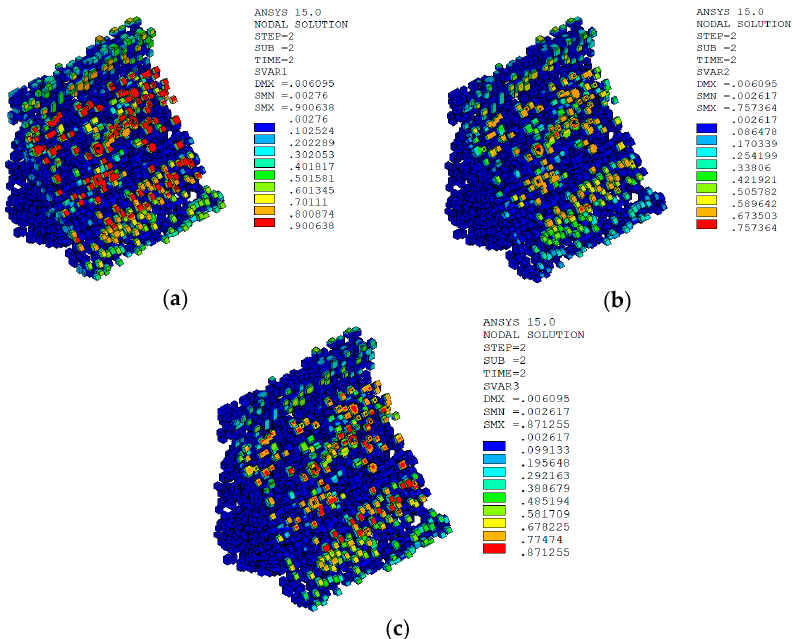
Figure 16. The temperature damage distribution of the ITZ material in the three principal strain directions is calculated by the macro-meso model under the temperature drop condition, ( a ) The temperature damage distribution in the first principal strain direction, ( b ) The temperature damage distribution in the second principal strain direction, ( c ) The temperature damage distribution in the third principal strain